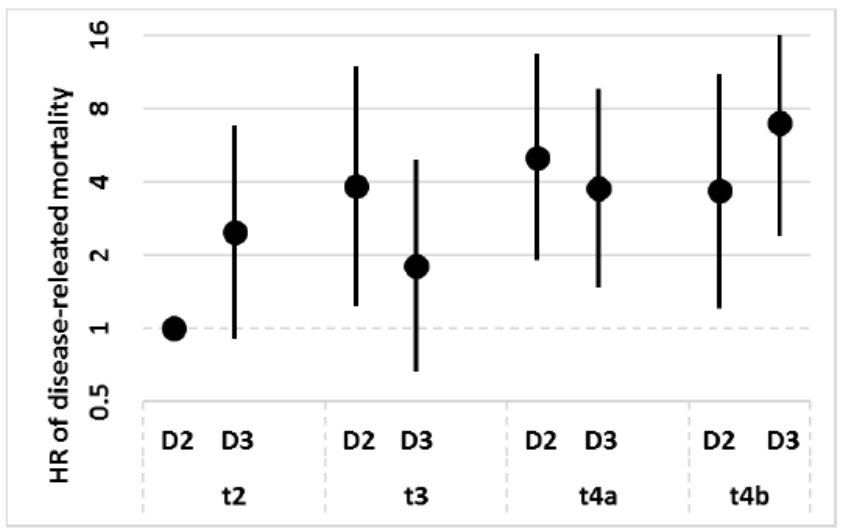
Figure 2. Hazard ratios (HRs) of disease-related deaths as a function of T tier and the extension of lymphadenectomy. The HRs were derived from a Cox regression model controlling for sex, age, tumor site, Laurén histotype, and N stage. The points are HRs and the bars are their 95% confidence intervals.